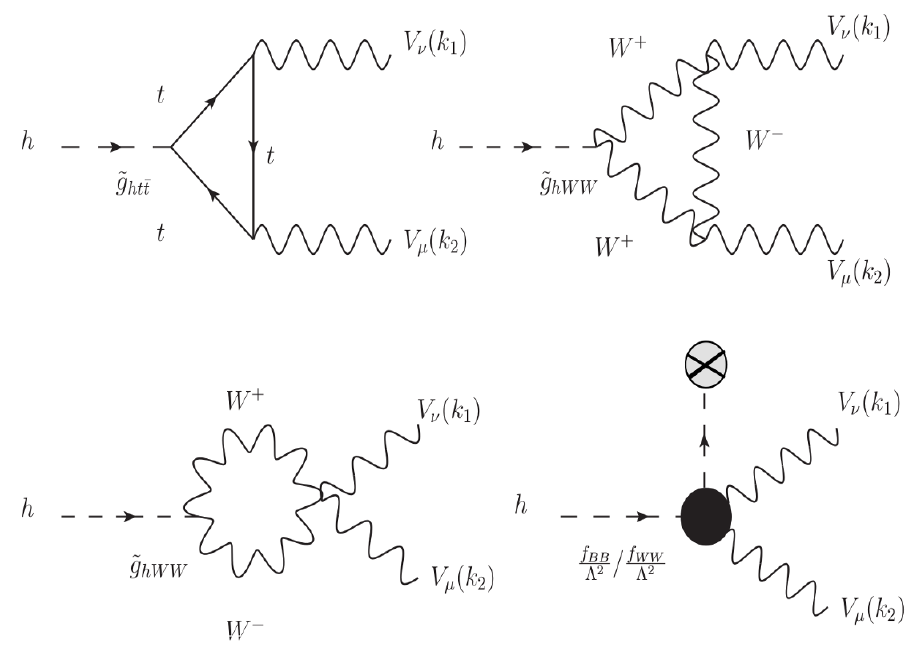
Figure 1 . Feynman diagrams for h ! (cid:13)(cid:13) and h ! Z(cid:13) in the most general situation. Contributions mediated by (cid:12)elds other than those in SM are lumped in the